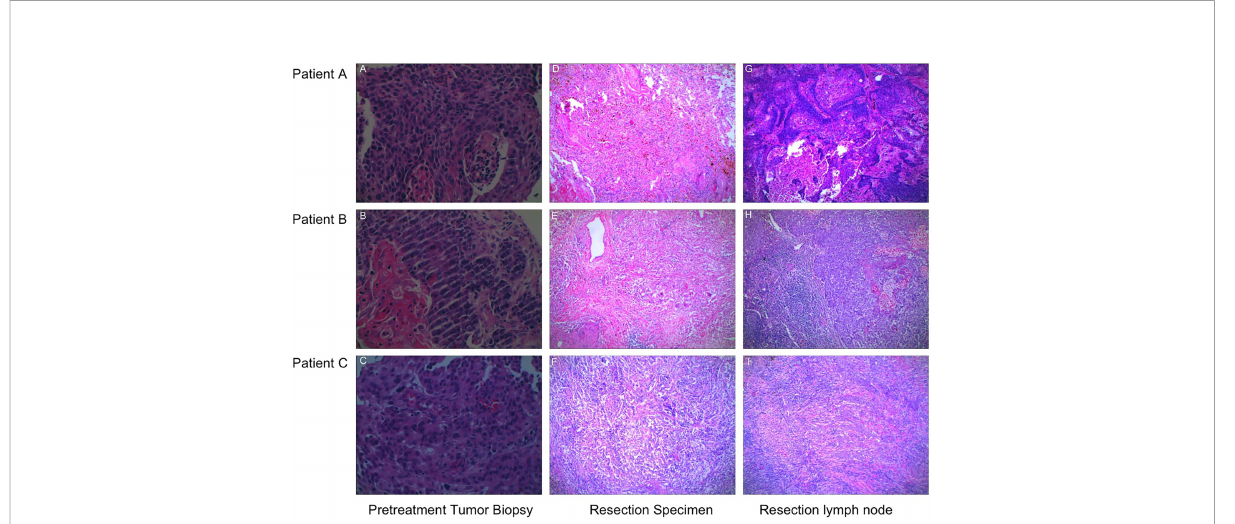
FIGURE 2 The representative sections of tumor specimens from three patients before and after the administration of camrelizumab plus chemotherapy. (A – C) Pretreatment tumor biopsy, HE staining (×400). (D – E) The resection specimens were in fi ltrated by lymphocytes and macrophages, and there were over 90% tumor tissue regression, HE staining (×100). (F) Over 50% residual tumor cells were present, and a little fi brous tissue can be observed, HE staining (×100). The presence of necrosis, fi brosis, and macrophages was observed in the metastatic lymph nodes of patients with MPR (G, H) , whereas this founding was not observed in the patient without MPR (I) , HE staining